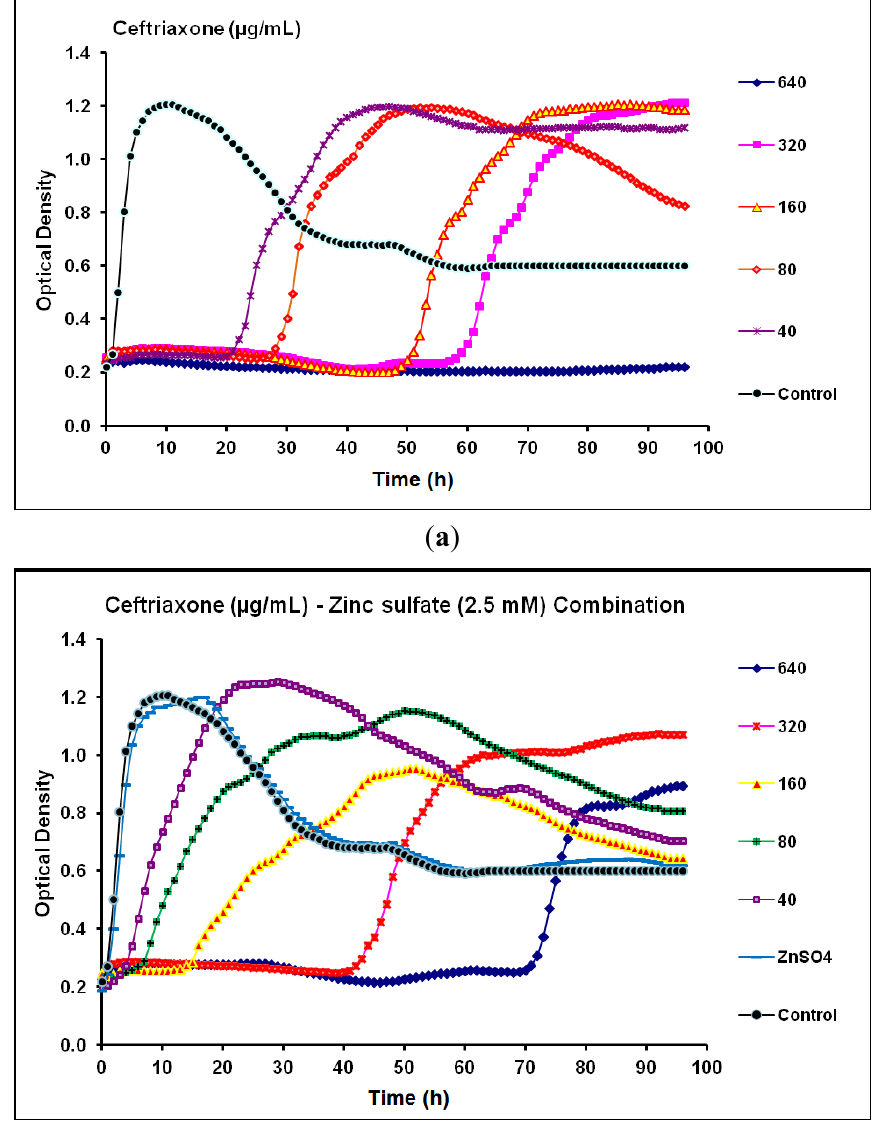
Figure 7. Real-time data showing the effect of ( a ) Ceftriaxone alone (40–640 µg/mL) and ( b ) Ceftriaxone (40–640 µg/mL) in combination with zinc sulfate (2.5 mM) on P . aeruginosa CCIN34519 biofilm as monitored by the Bioscreen C over 96 h. Control represents cation adjusted Mueller Hinton II broth (CAMH) while, ZnSO CAMH broth supplemented with 2.5 mM zinc